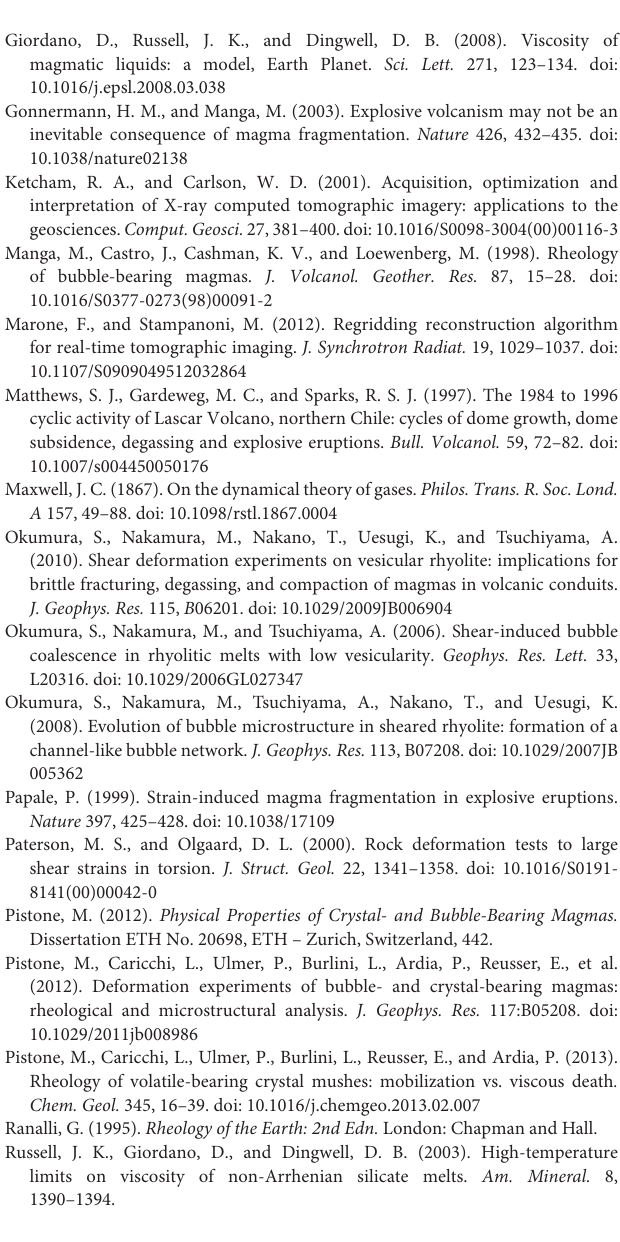
microstructural domain: highly deformed bubbles within the shear band and presence of fractured crystals due to intensive particle collisions during deformation in the less deformed sample regions (as inferred by the bubble shape; Pistone et al.,